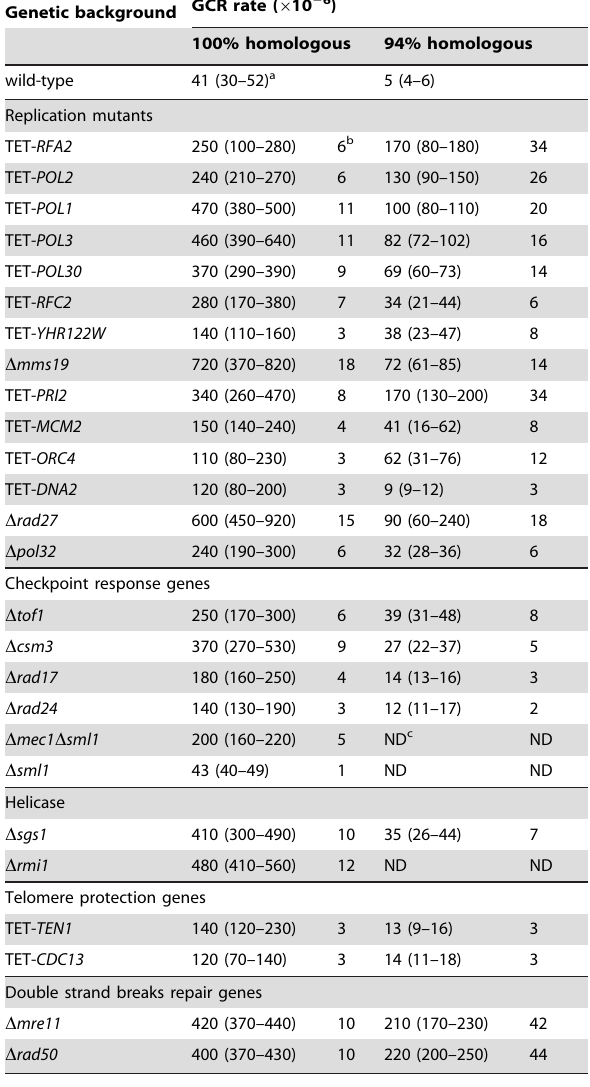
Table 1. Mutants with increased Alu -IR-induced GCR